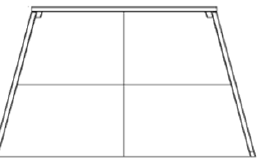
Figure 14. Schematic diagram of the layout of the cross measuring point method.